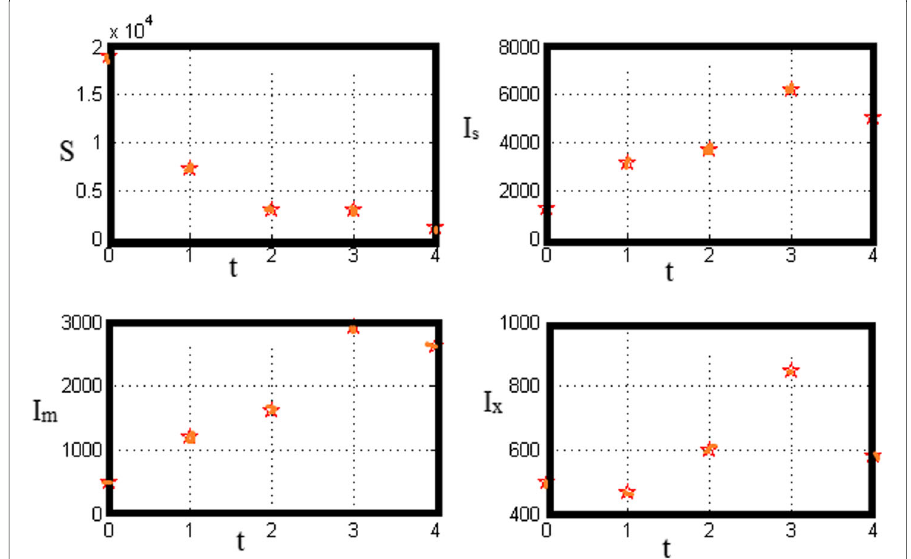
Fig. 9 The approximate solutions with θ = 0.5, ξ = 0.5, h = 1, by using